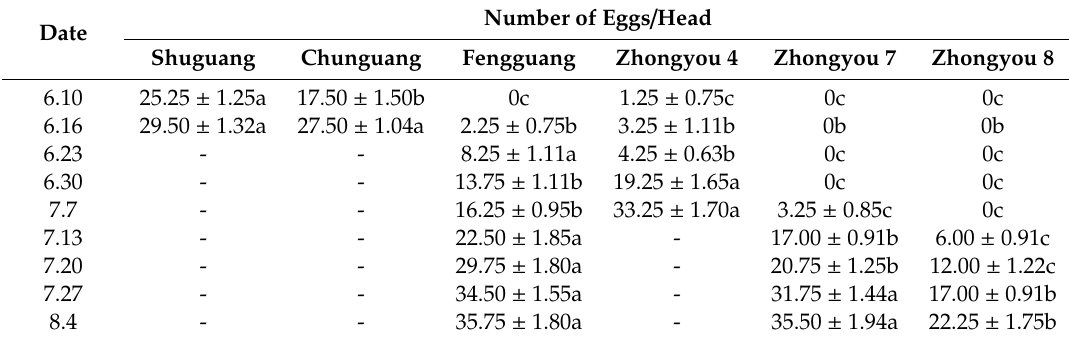
Table 3. The amount of eggs of D. suzukii on sliced nectarine varieties on the same collection date.